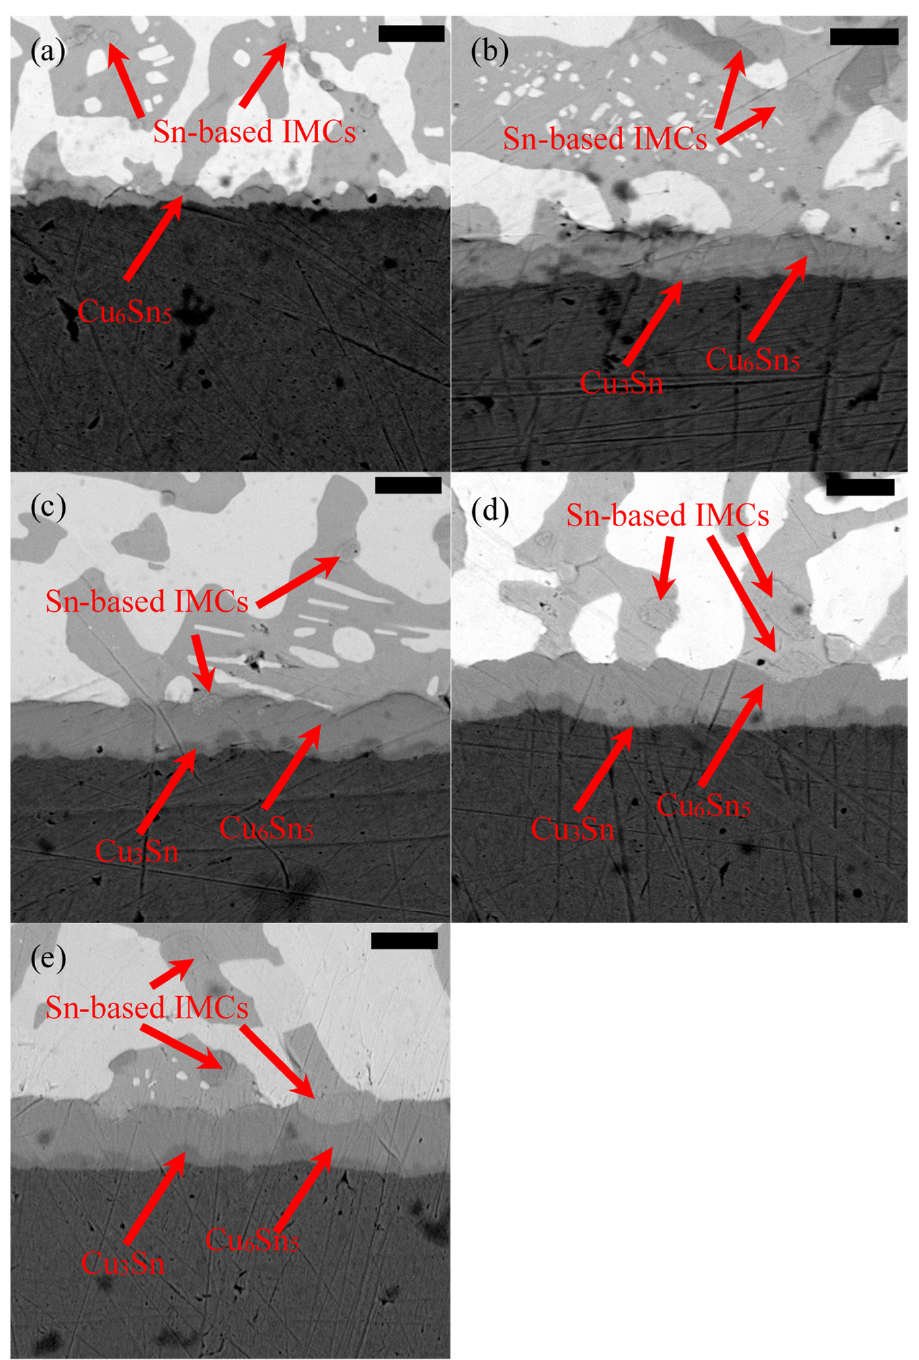
Figure 17. SEM micrograph of LT 51 after ( a ) 0 cycles, ( b ) 250 cycles, ( c ) 500 cycles, ( d ) 750 cycles and ( e ) 1000 cycles. The scale bar is 4 µm in all images. Table 4. % Area covered by Bi phases during each stage of thermal cycling.